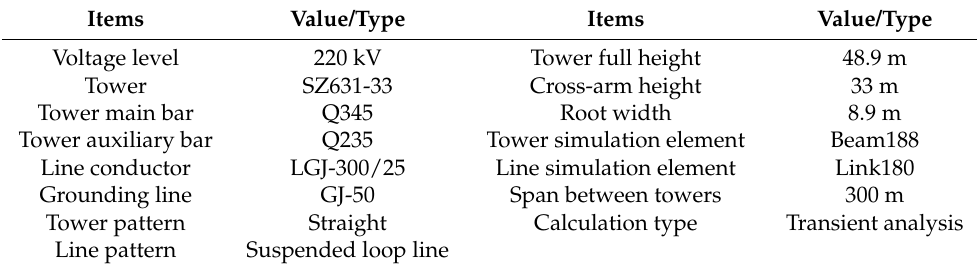
Figure 3. The process of the calculation program. Table 1. The parameters of the simulation